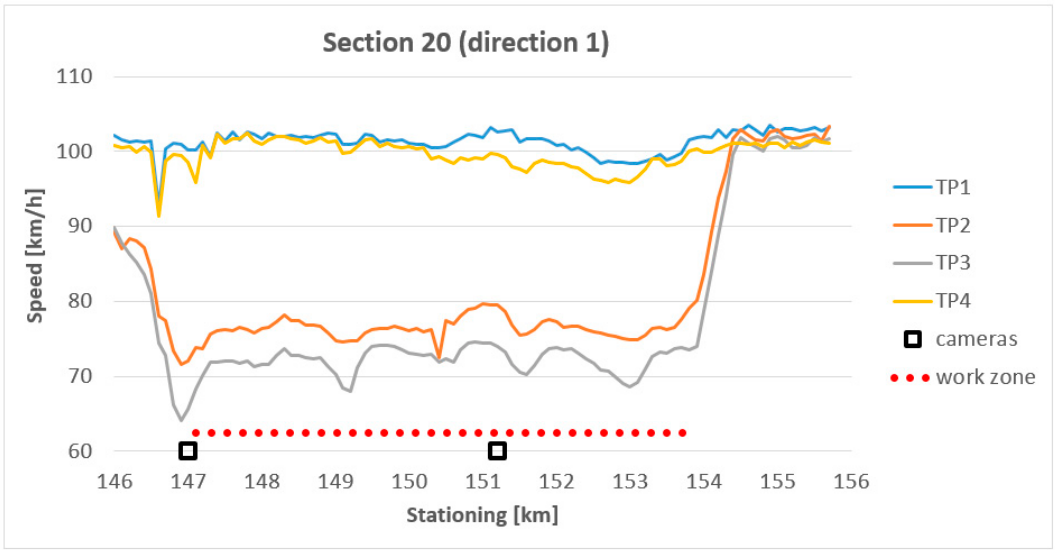
Figure 5. Example of a speed profile “in length”.